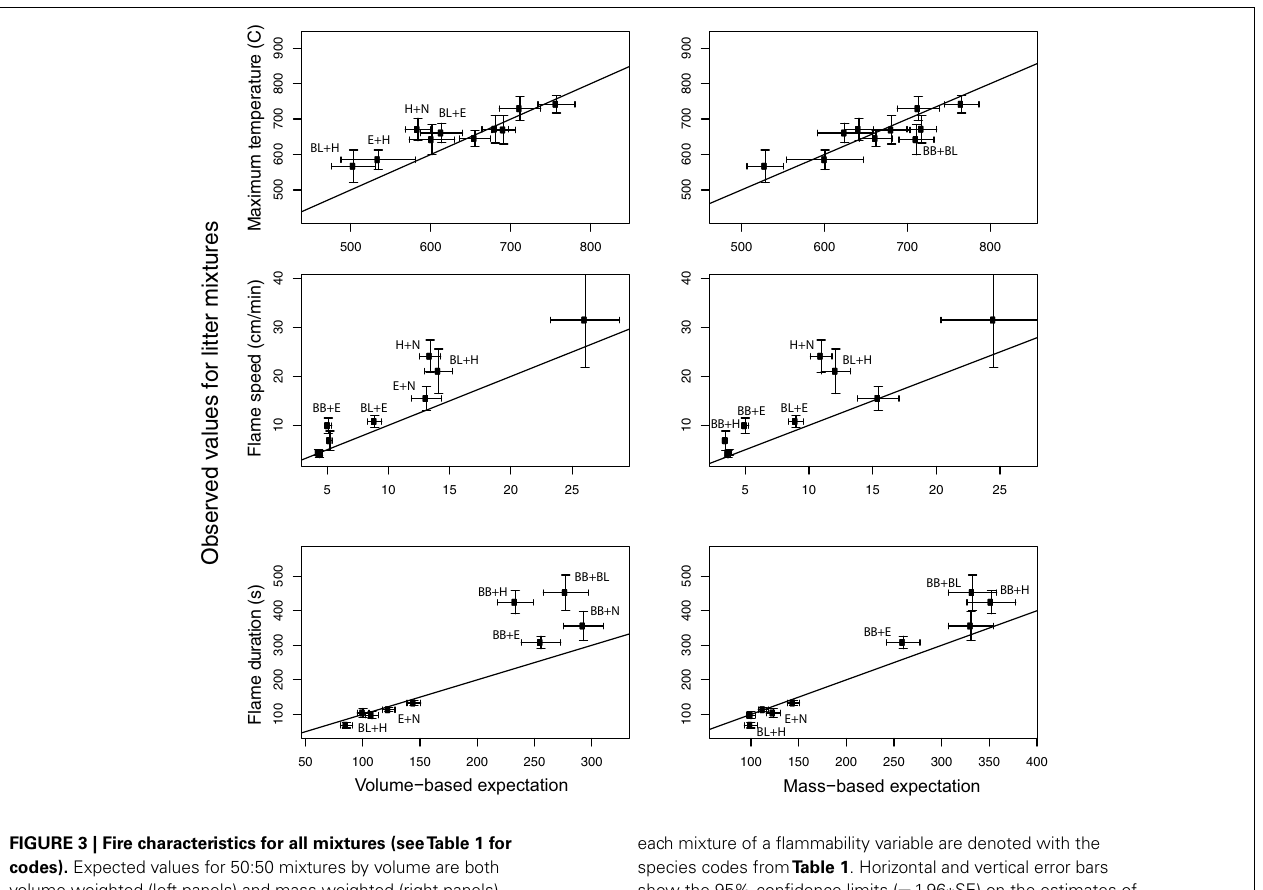
FIGURE 3 | Fire characteristics for all mixtures (seeTable 1 for codes). Expected values for 50:50 mixtures by volume are both volume-weighted (left panels) and mass-weighted (right panels). Significant differences between expected and observed values for